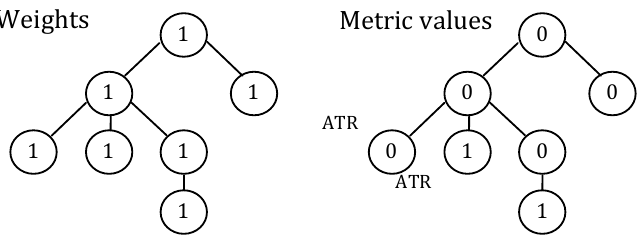
Fig 6. Calculation of the “number of attributives” as a node-based sentence metric. In this example the result is 1x1+1x0+1x0+1x0+1x0+1x1+1x0=2.